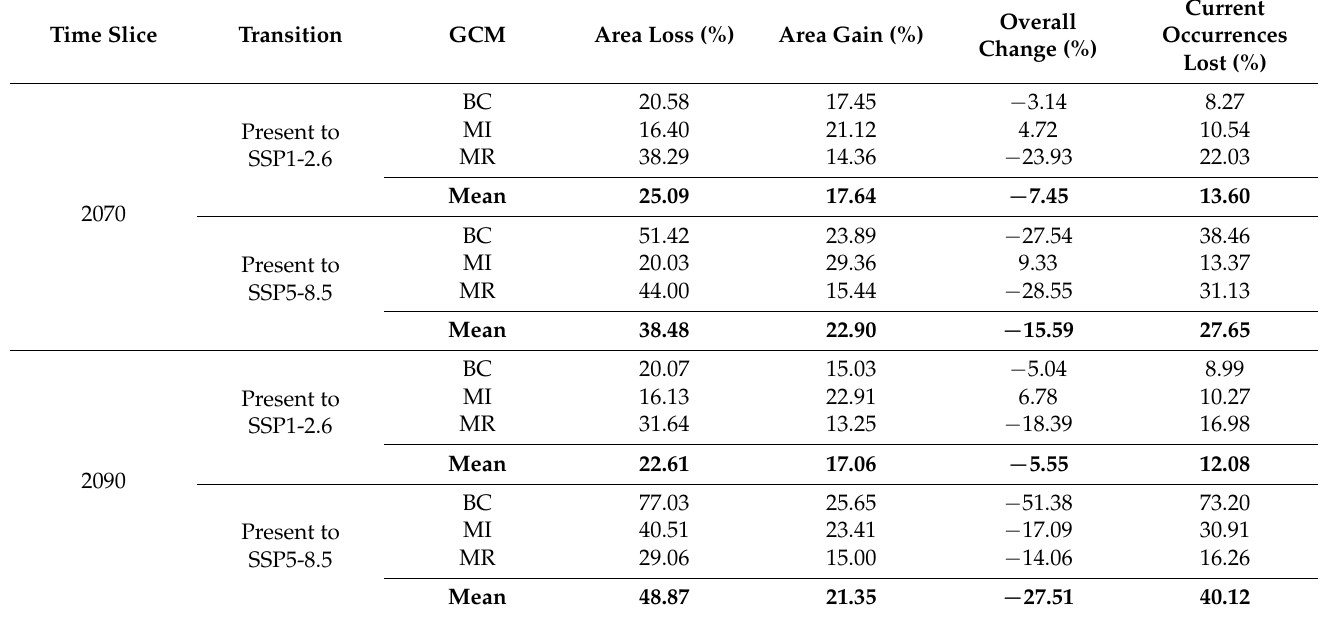
Table 1. Percentages of area loss, gain, overall area change and current occurrences lost for future projections of Ophrys insectifera . For the future, 2 time slices, 2070 (2061–2080) and 2090 (2081– 2100), are presented for all selected global circulation models (BC: BCC-CSM2-MR, MI: MIROC- ES2L, MR: MRI-ESM2-0) and two shared socioeconomic pathways (SSP1: best-case scenario, SSP5: worst-case scenario). The presented values are for the ensemble model with the environmental thinning